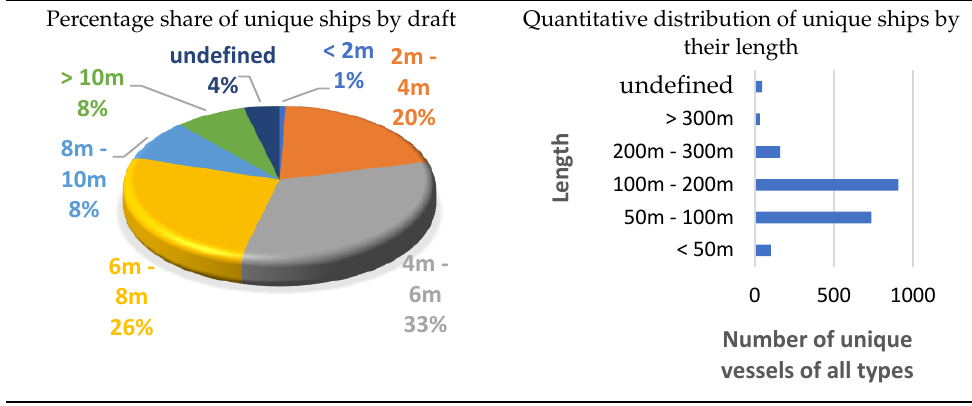
Table 14. Qualitative characteristics of all types of ships. Percentage share of unique ships by draft